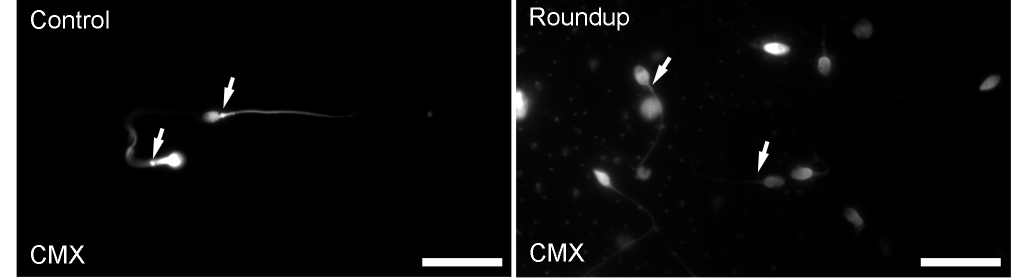
Figure 2. A representative image of mitochondrial staining in human spermatozoa exposed to Roundup. The exposure of sperm samples to Roundup for 1 h caused a reduction in the mitochondrial incorporation of the CMX dye compared to the controls (white arrows), indicating that Roundup caused impairment in mitochondria of the midpiece of human spermatozoa. CMX: mitochondria staining. Bars indicate 20 μ m.